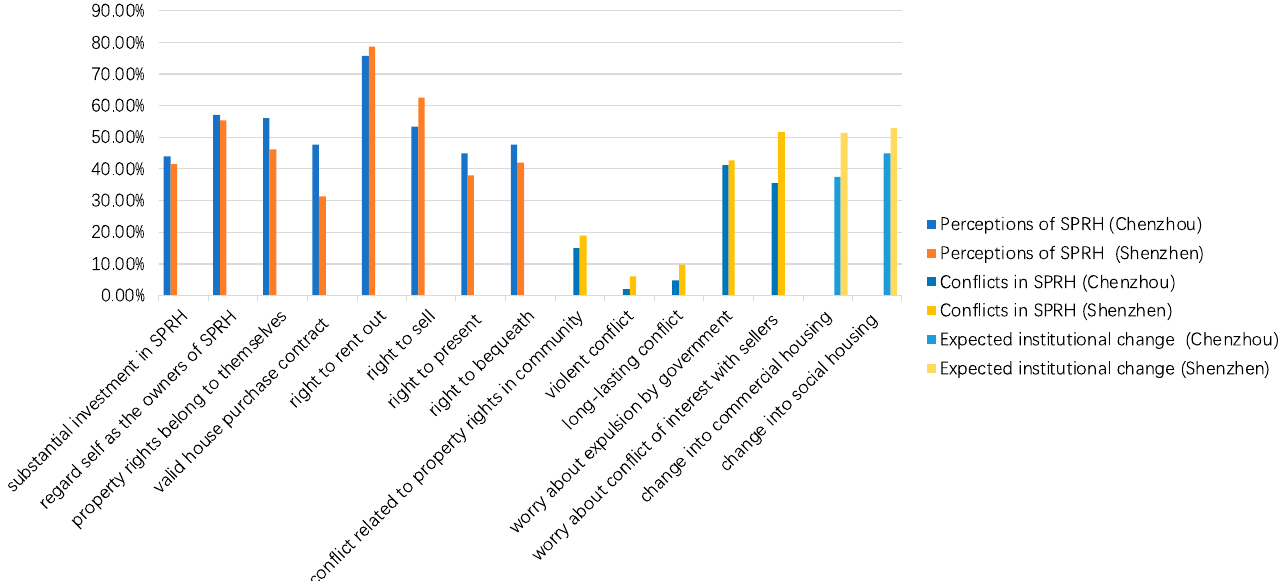
Figure 5. SPRH buyers’ perceptions of the intuition, the conflicts, and the change of SPRH in Chenzhou and Shenzhen. Meanwhile, divergent perceptions about the credibility of SPRH were returned by the respondents from the two cities. Compared with Chenzhou, a larger proportion of respondents in Shenzhen perceived conflicts and expected the change of SPRH into formal housing. The respondents in Chenzhou seemed to be more supportive of SPRH than their Shenzhen counterpart. Overall, the credibility of SPRH in Chenzhou looked higher than that in Shenzhen. However, the proportion of respondents in Shenzhen believing that they had the right to rent and sell SPRH was higher than that in Chenzhou. Both lease and sale are related to the usufruct of property. Combined with the fact that the respondents’ average income in Shenzhen was much higher than the city’s overall average, the findings suggest that not all the people who bought the informal housing in Shenzhen were low- incomers who saw SPRH as their passive choices. Some of them did not apply for social housing and could actually afford commercial housing. The buyers of SPRH may also come from the high-income group who actively choose SPRH for investment. This cir- cumstance reflects the investment function of SPRH in Shenzhen for risk-loving investors. The descriptive statistics of the three components of SPRH credibility, resultant OSP, and various independent variables are shown in Table 3. Overall, the average score for buyers’ perceptions about SPRH was 4.02 (out of 8). The average score for conflicts was 1.21 (out of 5), implying a low level of conflicts perceived by the respondents. Less than half of the respondents showed willingness to move from SPRH to formal housing insti- tutions, thus the mean score of expected institutional change was less than 1 (out of 2). Considering the commercial housing price and the respondents’ annual income, it will take residents of SPRH an average of 30 years to save money for purchasing a commercial housing unit of 100 square meters. While few of them may need only 2 years to buy com- mercial housing, the longest time required can be 300 years. The ratio of the SPRH price to the commercial housing price ranged from 0.04 to 1.33, with an average of 0.306, indi- cating that the price of SPRH is significantly lower than that of commercial housing. On average, the price of SPRH is just about one-third of the price of commercial housing only. The average score of the availability of social housing was 3.22 (out of 5), which means that social housing is perceived as being relatively easy for most people to obtain success- fully.